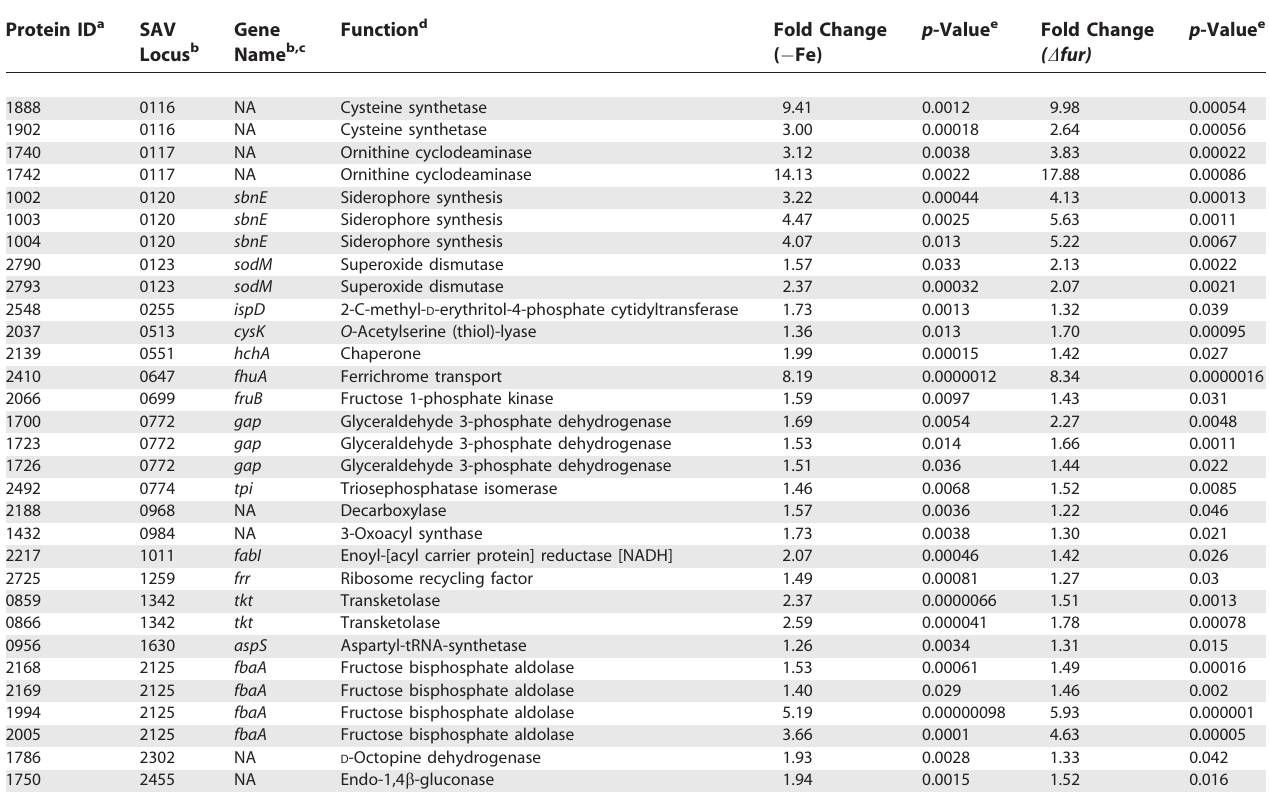
Table 2. Proteins Negatively Affected by Fur and Iron Protein ID a SAV Gene Function d Fold Change Locus b Name b,c